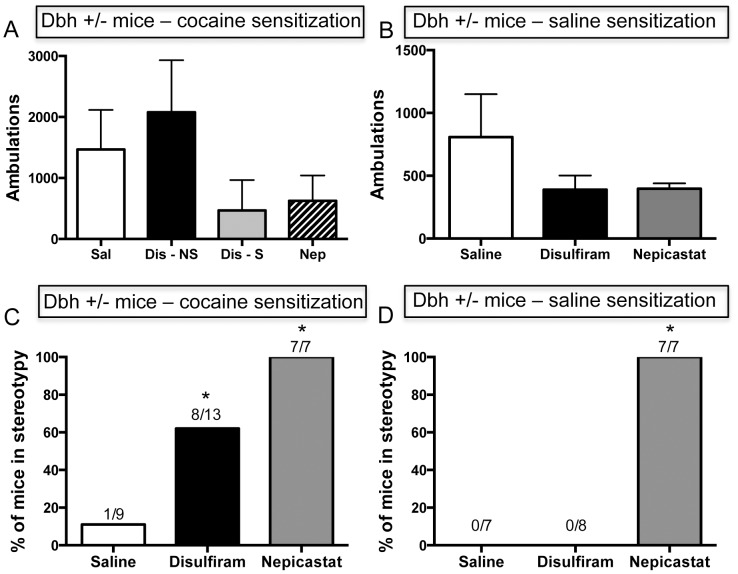
Effects of chronic disulfiram or nepicastat administration on cocaine-induced locomotor activity and stereotypy in Dbh +/− mice during the expression of sensitization.Ten days following the 5 day sensitization paradigm (see Fig. 3 legend), all mice were placed in the activity chambers for 30 min, given an injection of cocaine (15 mg/kg, i.p.), and locomotor activity was recorded for 2 hr and stereotypy was scored. (A) Mean ± SEM ambulations for mice in the groups that received cocaine injections during the 5 day sensitization period (saline+cocaine (“Sal”), n = 9; disulfiram+cocaine that did not display stereotypy (“Dis - NS”), n = 5; disulfiram+cocaine that displayed stereotypy (“Dis - S”), n = 8; nepicastat+cocaine (“Nep”), n = 7). (B) Mean ± SEM ambulations for mice in the groups that received saline injections during the 5 day sensitization period (saline+saline, n = 7; disulfiram+saline, n = 8; nepicastat+saline, n = 7). (C) Percentage of mice in the groups that received cocaine injections during the 5 day sensitization period (saline+cocaine, disulfiram+cocaine, nepicastat+cocaine) that primarily engaged in stereotypy. (D) Percentage of mice in the groups that received saline injections during the 5 day sensitization period (saline+saline, disulfiram+saline, nepicastat+saline) that primarily engaged in stereotypy following cocaine challenge. * p<0.05 compared with the saline control for that group (saline+cocaine for panel C, saline+saline for panel D).